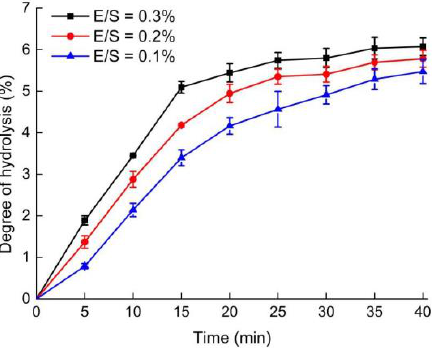
Figure 1. Degree of hydrolysis (DH) of oyster protein isolate (OPI) hydrolysis with different ratios of enzyme to substrate (E/S) (0.1%, 0.2%, 0.3%, w / w ). The protein concentration of OPI was 10% ( w / v ).